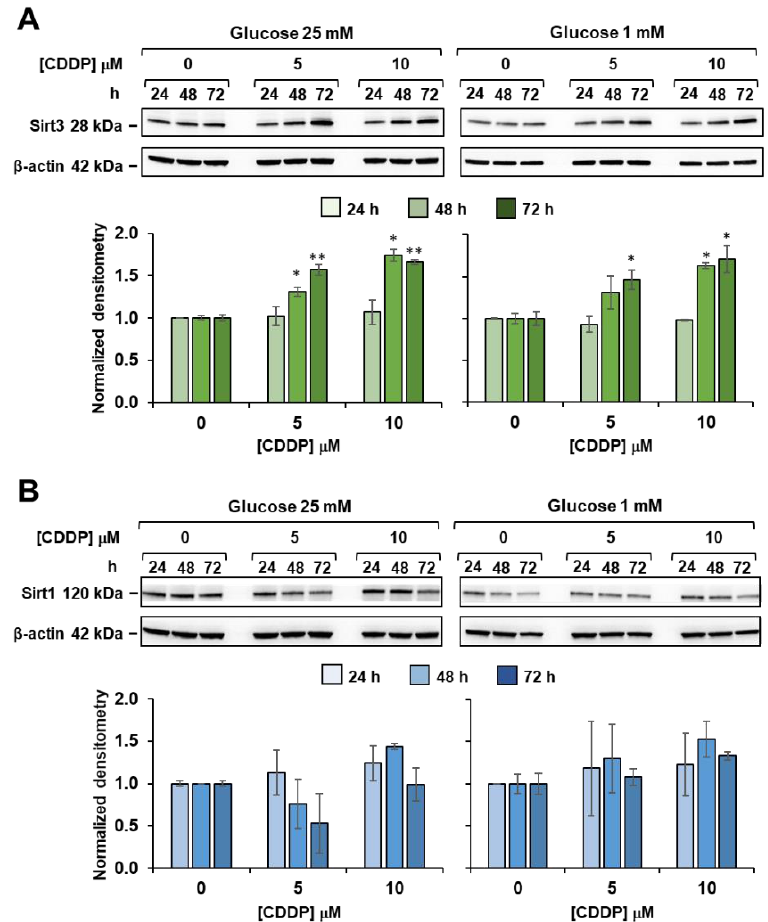
Figure 9. Effect of cisplatin on sirtuins expression in 3AB-OS under high and low glucose growth conditions. Cells were treated with different concentrations of cisplatin (CDDP) and glucose regimen as indicated; whole cell proteins were extracted at the specified time points and subjected to SDS-PAGE and blotted toward either SIRT3 ( A ) or SIRT1 ( B ). Upper panels in (A) and (B) are representative cropped immunoblots of Sirt3 and Sirt1 respectively; lower panels are graph bars showing the average ± SD of data resulting from densitometric analysis (normalized to β -actin) of three independent biological replicates under each condition. Statistical significances are referred to the relevant controls; * p < 0.05, ** p < 0.01.